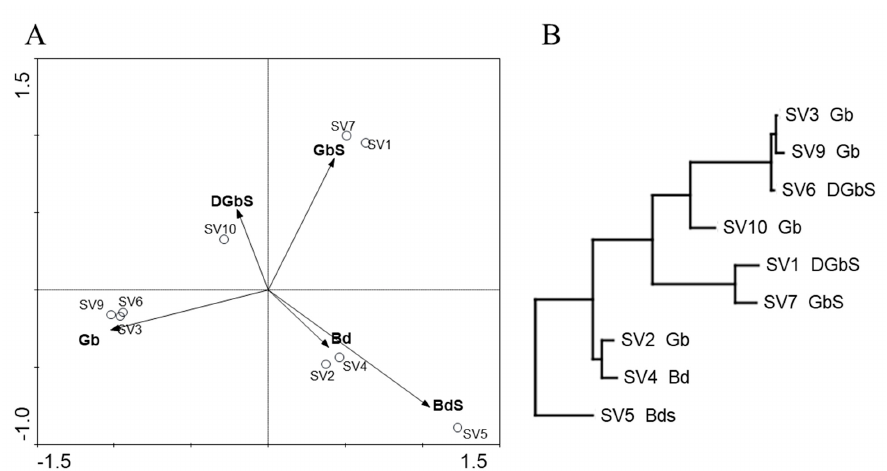
Figure 4. ( A ) Principal component analysis (PCA) and ( B ) neighbor − joining dendrogram based on the Euclidean distance for domain Archaea OTU profiles. Biofilm classification was used as an environmental variable for PCA and is displayed with each sample designation in the dendrogram (GbS: Green biofilm with visible salt efflorescence; Gb: Green biofilm; DGbS: Dark and green biofilm with visible salt efflorescence; Bd: Black discoloration).